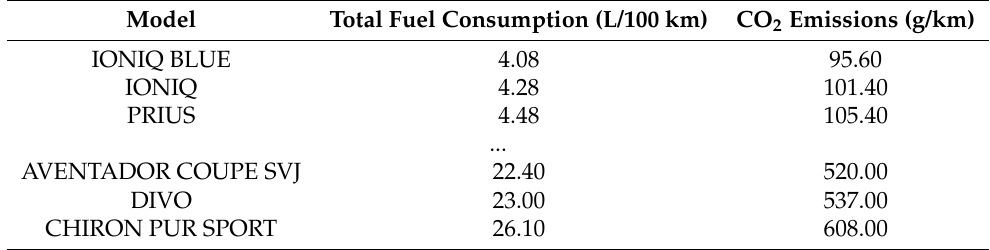
Table 3. CO 2 emissions (g/km) and total fuel consumption (L/100 km) of each model.